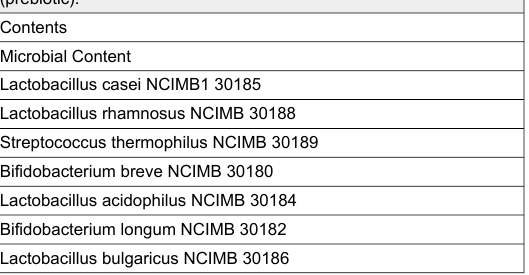
Table 1: Microbial content of the synbiotic mixture (protexin capsule). In addition to probiotics, it also contains Fructooligosaccharide